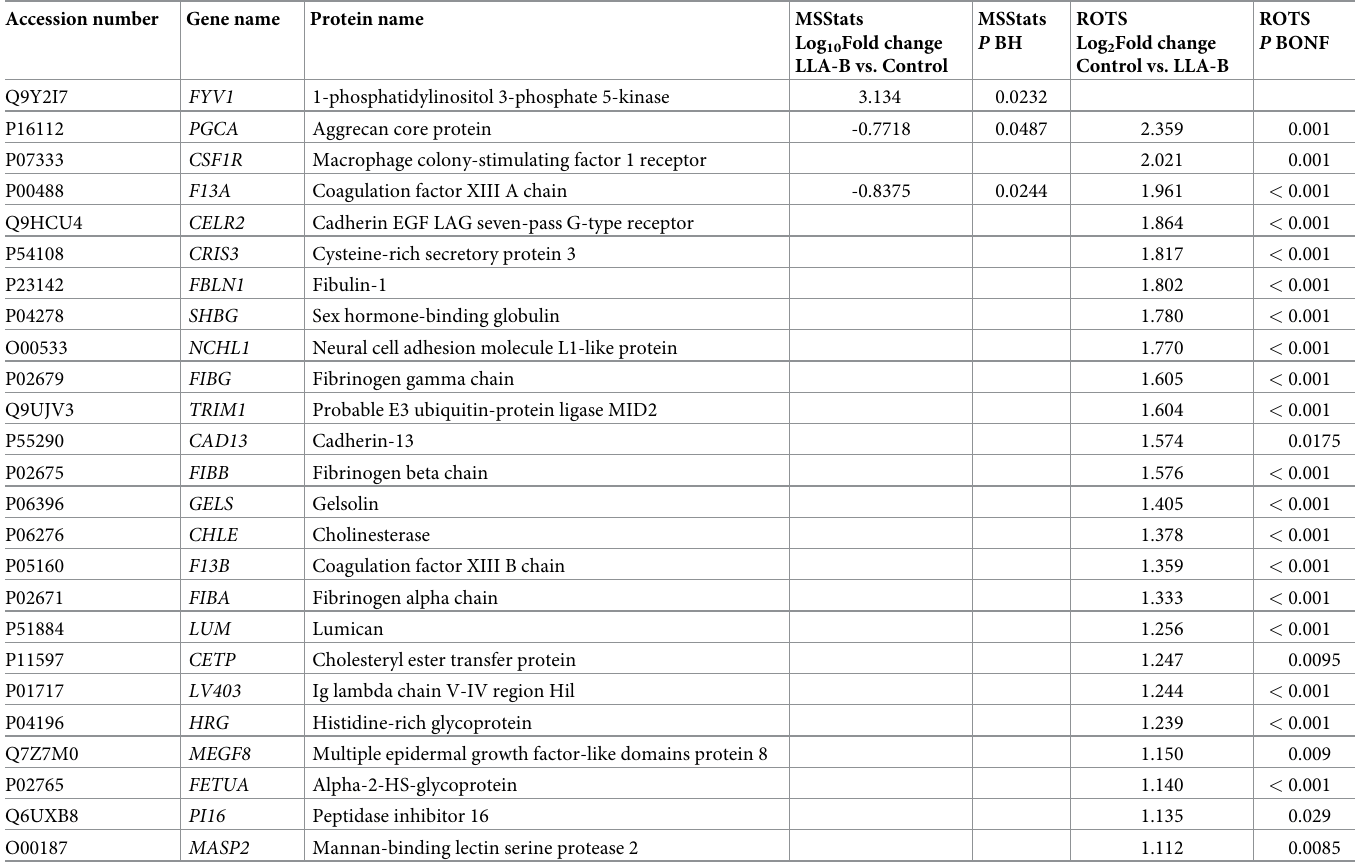
Table 2. Differentially expressed proteins between B-ALL and control